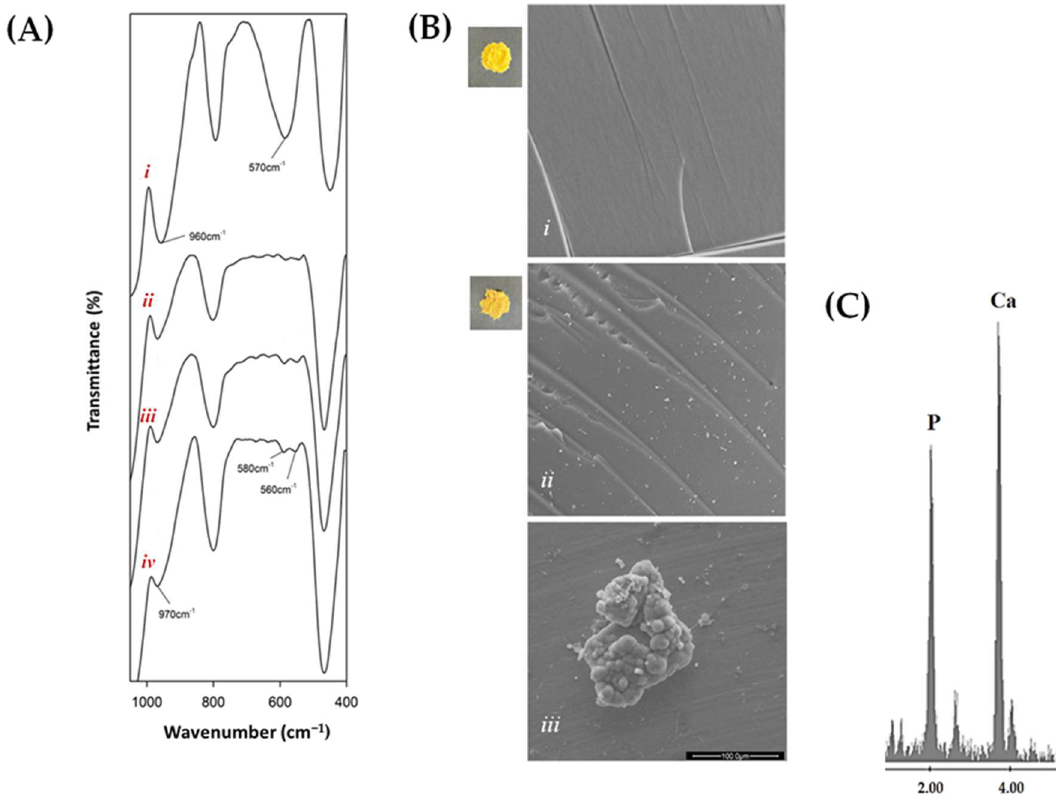
Figure 3. ( A ) FTIR spectra of ( i ) SiO 2 ; ( ii ) SC10P6; ( iii ) SC10P12; ( iv ) SC10P24; ( B ) representative SEM micrographs of ( i ) SC10, ( ii ) SC10P12, and ( iii ) SC10P12, after the three-week soaking in SBF. ( C ) EDS spectrum of the SC10P12 hybrid following the three-week exposure to SBF.